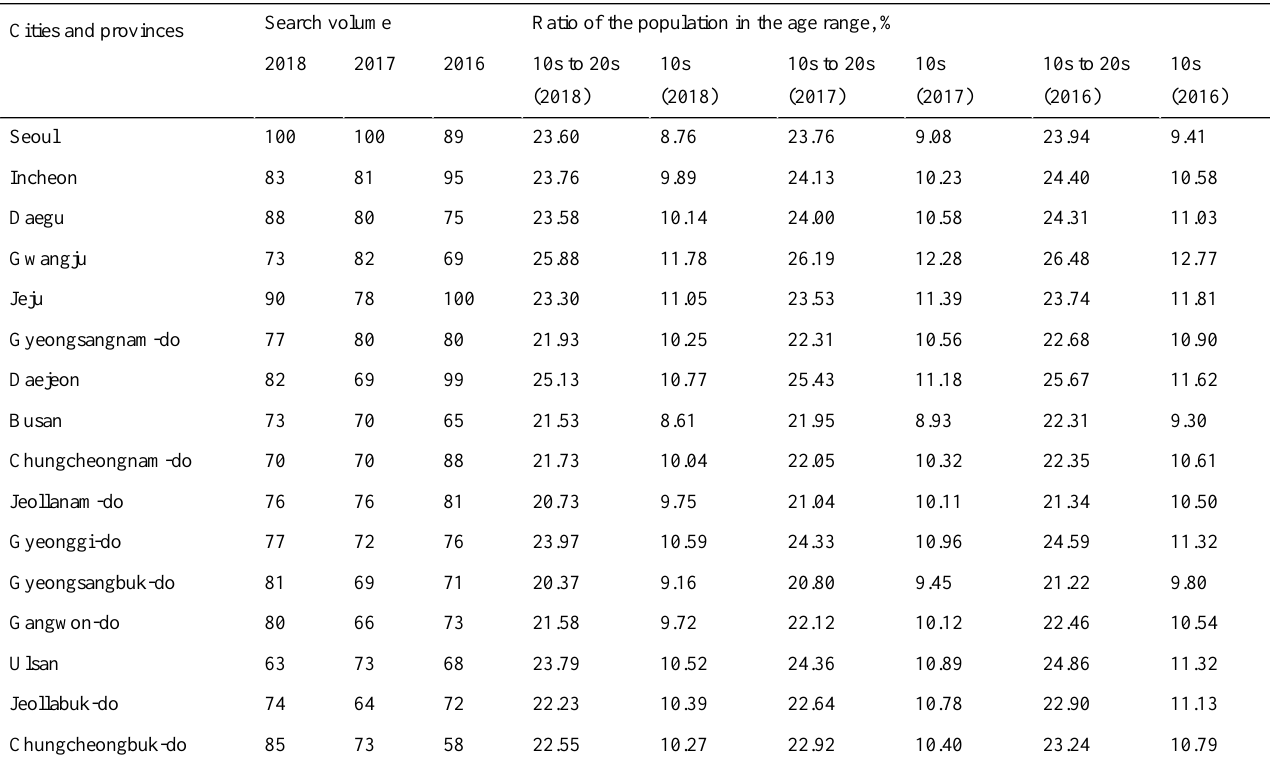
Table 2. Acne vulgaris search volume and population composition in cities and provinces.